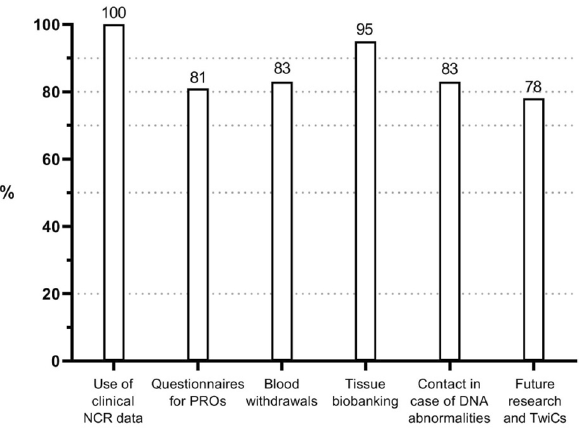
Figure 3. Baseline informed consent percentages per item. The use of clinical NCR data is 100% since this item is mandatory for participation. NCR Netherlands Cancer Registry, PROs patient-reported outcomes, TwiCs Trials within